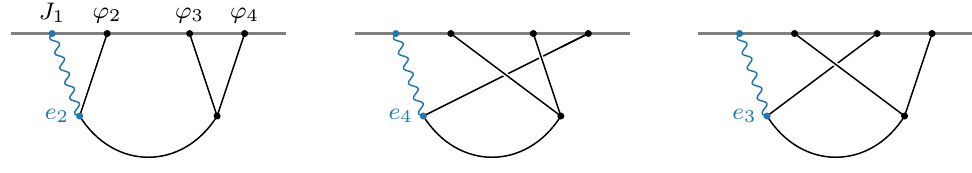
Figure 5: Diagrammatic representation of the s , t , and u -channel contributions to 〈 J ϕϕϕ 〉